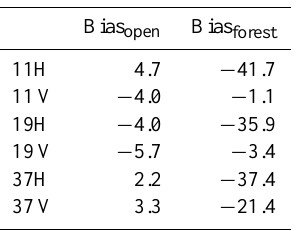
Figure 12. Simulated T B in forested sites neglecting the vegetation contribution ( T B,down ) . Table 12. Comparison between the calculated biases in an open area and in a forested area.